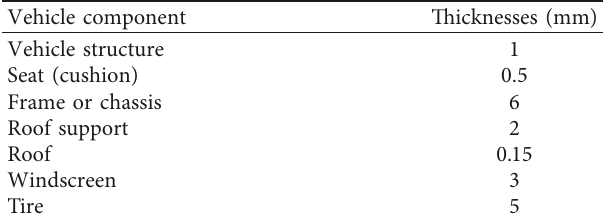
Table 2: Thicknesses of the vehicle components.